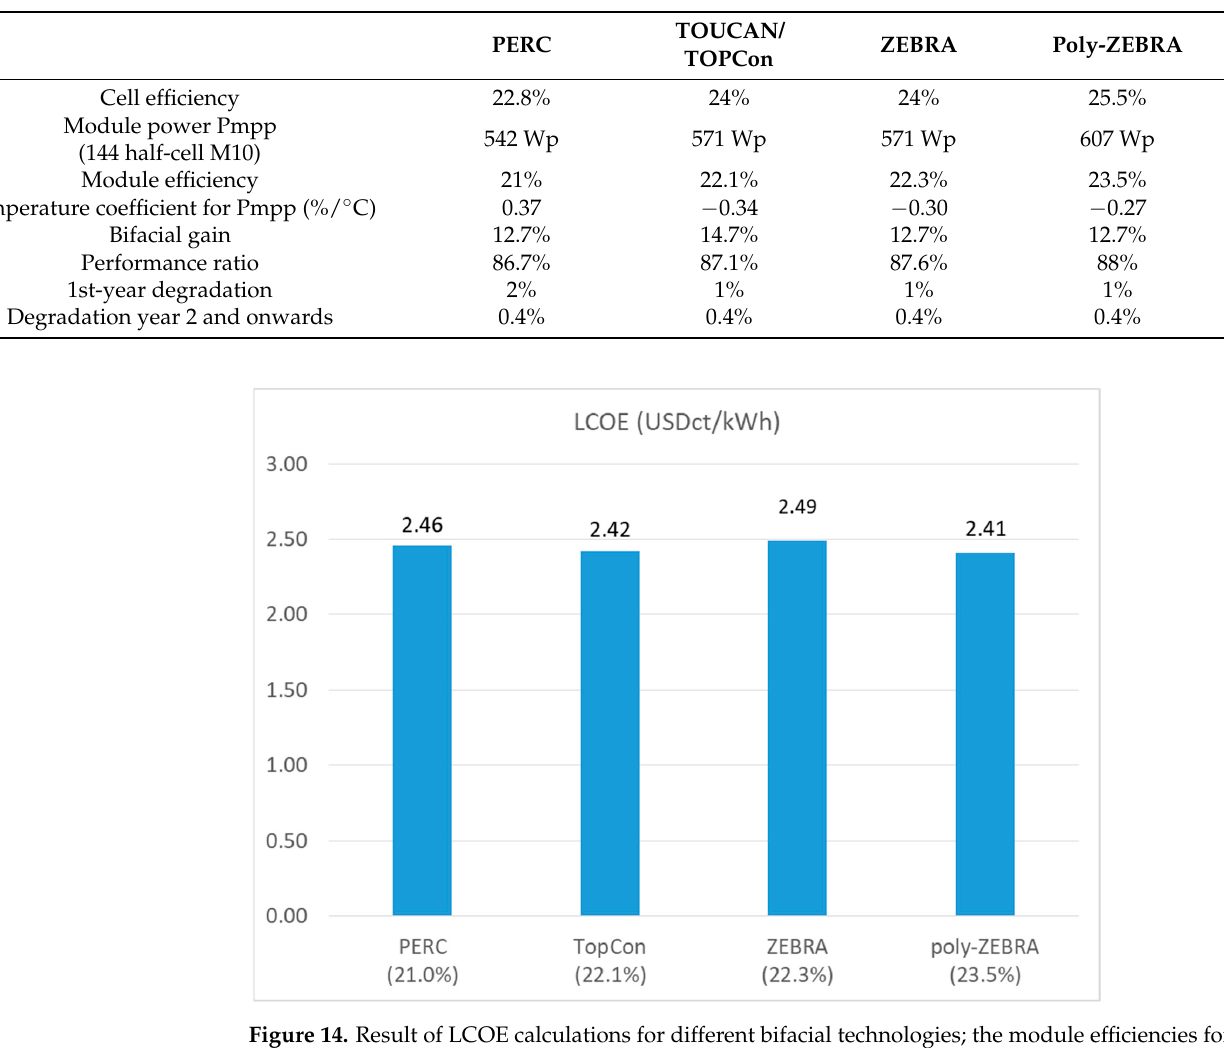
Table 6. Technology specific assumptions for LCOE.